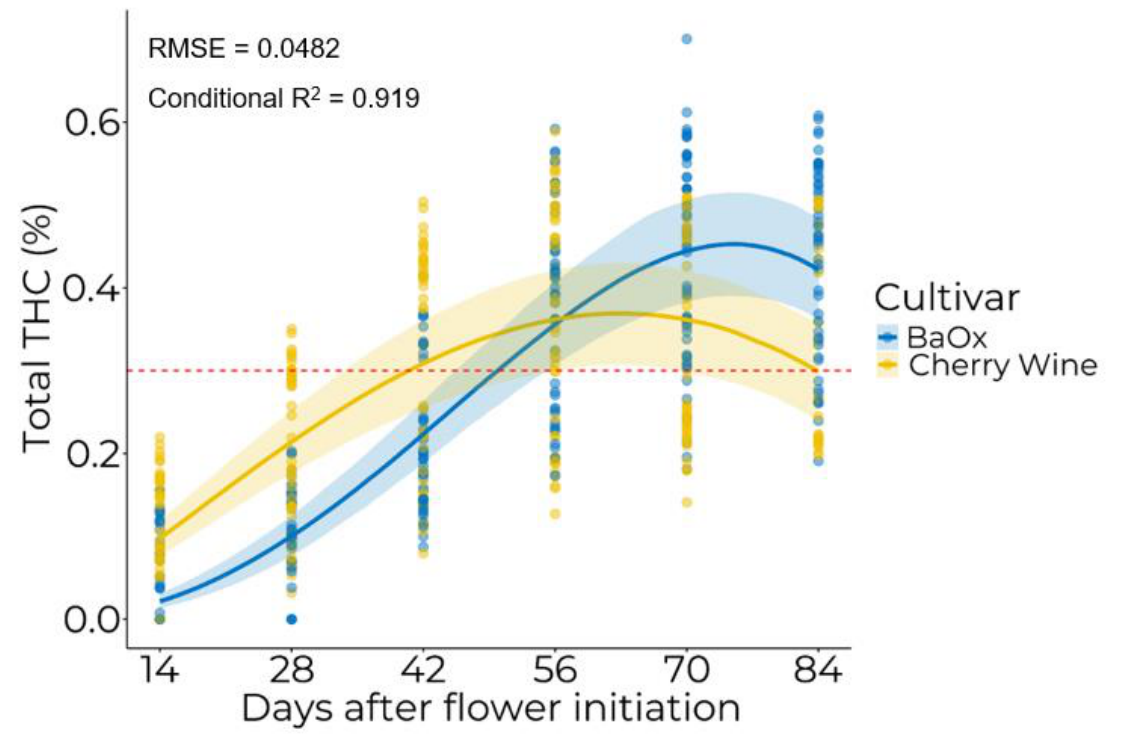
Figure 2. Beta growth curve nonlinear function for floral hemp total THC concentration over time as affected by cultivar. Red dashed line at 0.3% total THC represents the legal threshold. Shaded area represents 95% confidence interval for the predicted model. Circles represent plot-level data points. RMSE = Root Mean Square Error.